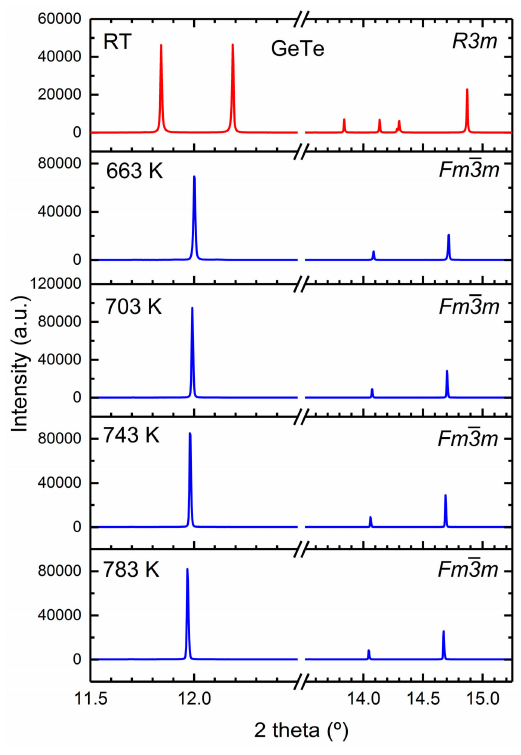
Figure 5. Thermal evolution of selected regions of the SXRD patterns of GeTe, in which a rhombohedral to cubic phase transition is evidenced.